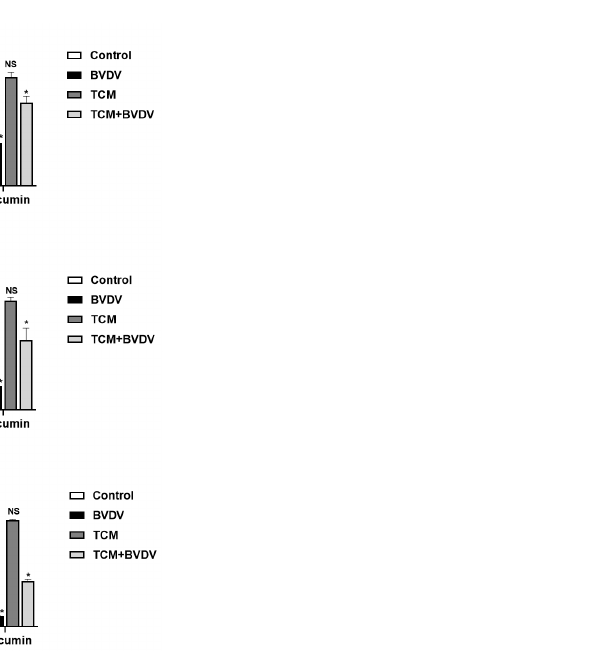
Figure 8. E ff ect of TCM monomer on the blood indexes of mice. ( A ): White blood cells (WBC). ( B ): Lymphocytes (LYM). ( C ): Platelets (PLT). TCM (Traditional Chinese Medicine). NS: The di ff erence was not significant. *** p < 0.001, * p < 0.01, n = 3. Data were presented as mean ± SD.